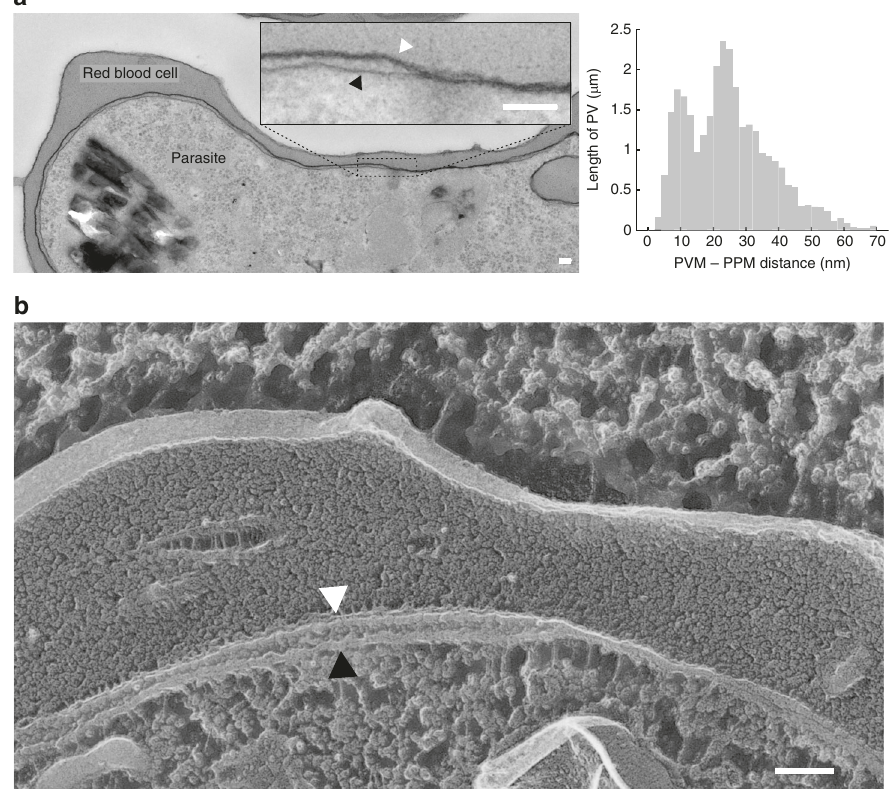
Fig. 1 The PV exhibits two structurally distinct regions. a (left) Thin section electron micrograph of a Plasmodium falciparum (NF54attb) infected red blood cell. The inset highlights the PVM and PPM. (right) Histogram of the PVM-PPM distance collected from single sections of seven parasites in six images in regions where both membranes are cut at a right angle. The histogram y -axis is scaled to re fl ect length of the sampled PV: 29.4 µ m PV were sampled in total. The distribution can be fi t to a two-component mixture model (see methods) with mean 1 = 8.7 nm [8.3 nm, 9.1 nm] (mean [95% CI]) and mean 2 = 26.9 nm [26.6 nm, 27.3 nm]. b Freeze fracture of NF54attb. A region of PV lumen is visible in the left of the image and a region of close membrane apposition is visible in the right side. a , b Scale bars: 100 nm. White arrows heads to the PVM, black arrow heads to the PPM. Source data are provided as a Source Data fi